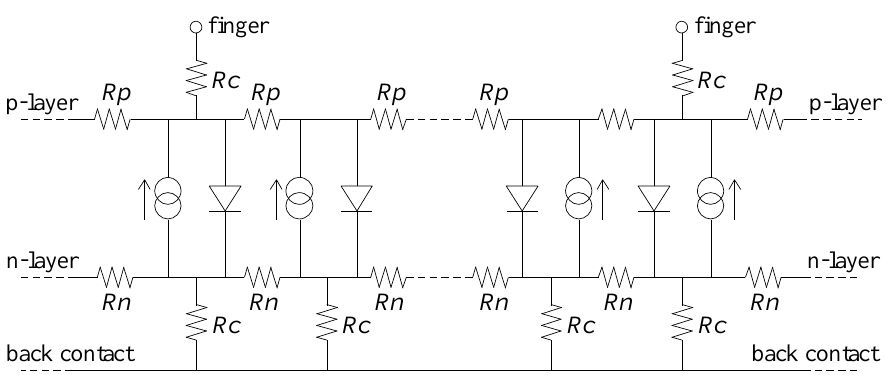
Figure 2. Distributed constant equivalent circuit.